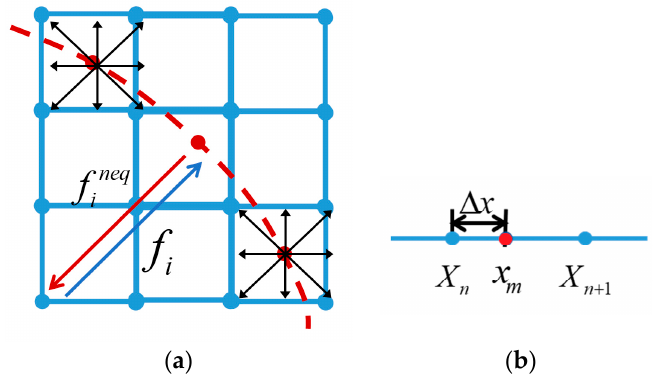
Figure 1. The proposed non-equilibrium scheme: ( a ) the interpolation and spread process in two dimensions; ( b ) the three-point interpolation in one dimension.